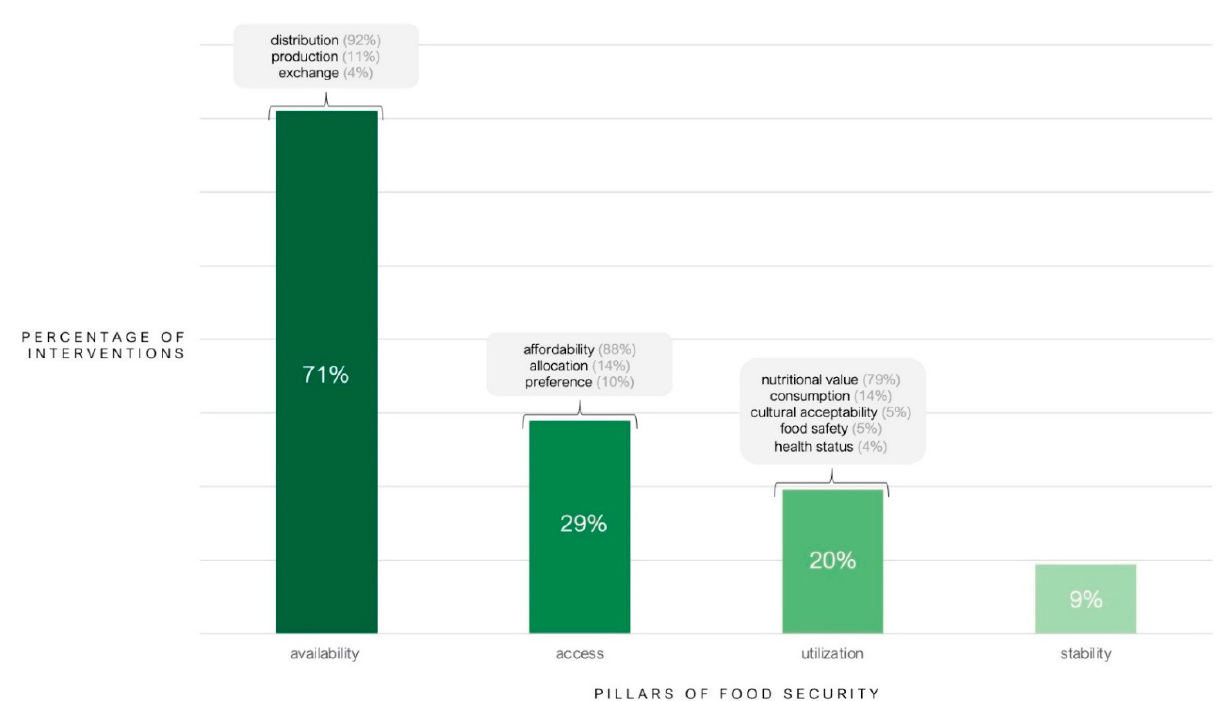
Figure 2. Pillar of food security addressed by interventions delivered by INGOs and UN agencies in response to the COVID-19 pandemic in low- and middle-income countries from 31 December 2019 to 31 May 2020 ( n = 287). Each category was not mutually exclusive. Thus, interventions could have incorporated more than one pillar of food security. Within each pillar of food security (i.e., availability, access, utilization, and stability), the various components comprising the pillar were calculated as proportions of the number of interventions in the corresponding pillar. For example, approximately 92% of all food availability interventions included food distribution.